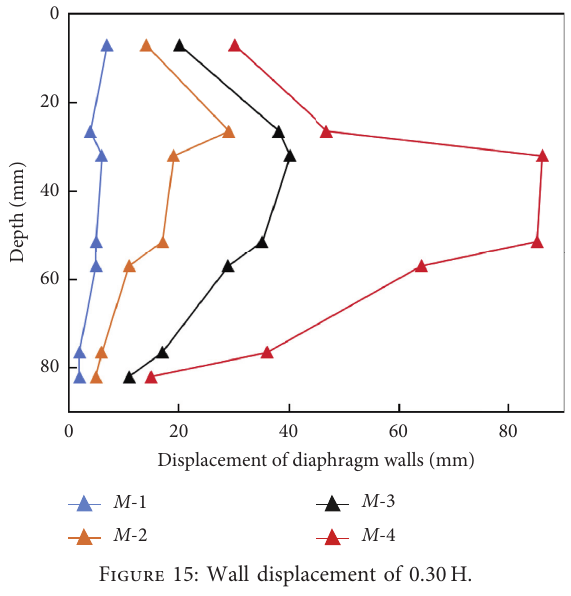
Figure 15: Wall displacement of 0.30H.